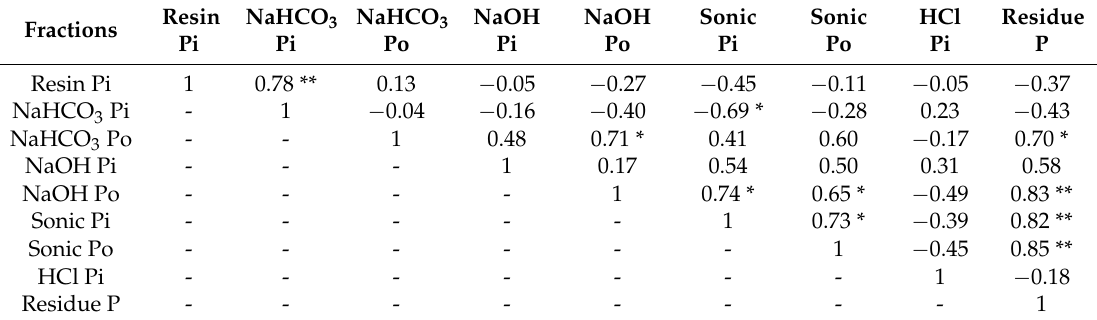
Table 4. Pearson correlation coefficients for soil P fractions (0–20 cm) in Brazilian Eucalyptus plantations. Resin NaHCO 3 NaHCO 3 NaOH NaOH Sonic Sonic HCl Residue Fractions Pi Pi Po Pi Po Pi Po Pi P Resin Pi 1 0.78 ** 0.13 ´ 0.05 ´ 0.27 ´ 0.45 ´ 0.11 ´ 0.05 ´ 0.37 NaHCO 3 Pi - ´ 0.04 ´ 0.43 NaHCO 3 Po NaOH Pi - - - - - - 1 ´ 0.39 Sonic Po - - - - - - 1 ´ 0.45 0.85 ** HCl Pi - - - - - - - 1 ´ 0.18 Residue P - - - - - - - - 1 Significant at ** p < 0.01; * p < 0.05. Table 5. Pearson correlation coefficients between P fractions and soil attributes (0–20 cm) in Brazilian Eucalyptus plantations. Fractions Clay C pH SB Al sat. CEC Resin Pi ´ 0.47 ´ 0.43 ´ 0.58 ´ 0.56 NaHCO 3 Pi ´ 0.69 * ´ 0.55 ´ 0.03 ´ 0.27 ´ 0.34 ´ 0.68 * NaHCO 3 Po 0.47 0.59 0.41 0.41 ´ 0.15 0.61 NaOH Pi 0.46 ´ 0.37 0.41 NaOH Po 0.79 **